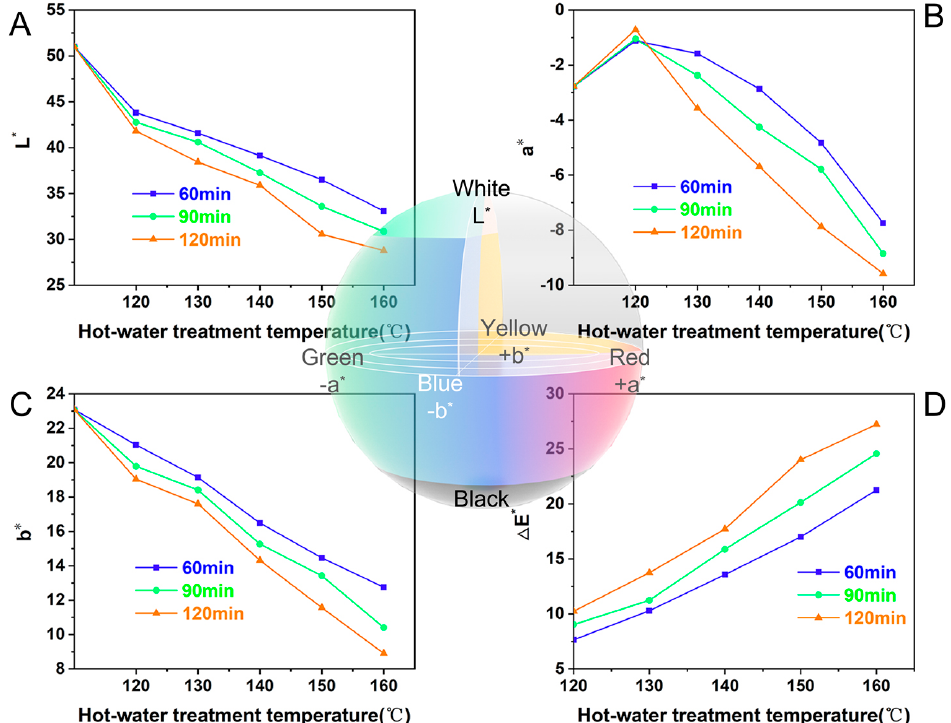
Figure 8. ( A ) Influence of different hydrothermal treatments on L*; ( B ) Effect of different hydrother- mal treatments on a*; ( C ) Effect of different hydrothermal treatments on b*; ( D ) Effect of different hydrothermal treatment on Δ E*.